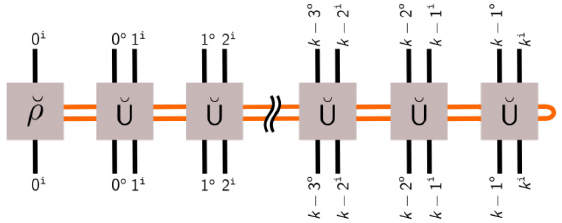
FIG. 31. MPO representation of a multitime process ϒ . Under the assumptions that all the unitaries in the process are the same—which, for example, holds true when the times are equidistantly spaced and the generating Hamiltonian is time independent, then the resulting process tensor can be written as ˘ U , together with a a product of an initial matrix ˘ ρ and matrices final partial trace (bent orange line on the right). The degrees of freedom that they share (orange lines) are the bond dimension of the MPO, the remaining open indices correspond to the spaces the resulting MPO lives on. The smallest bond dimension of all possible MPO representations of a given ϒ can be taken as a measure of non-Markovianity of ϒ